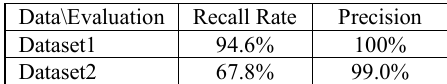
Figure. 6 Training Procedure of our proposed